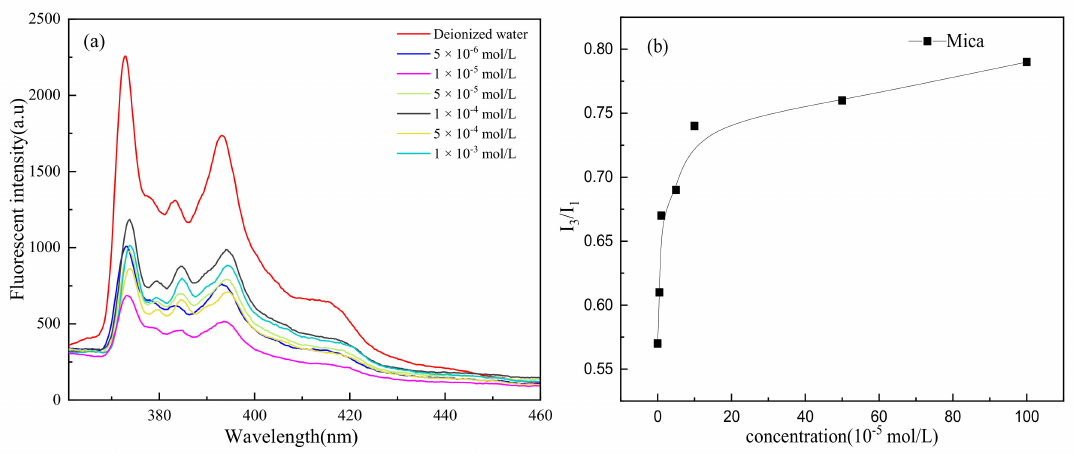
Figure 15. CTAC solutions of different concentrations. ( a ) Pyrene fluorescence spectra of muscovite. ( b ) I 3 / I 1 values of probe pyrene on muscovite